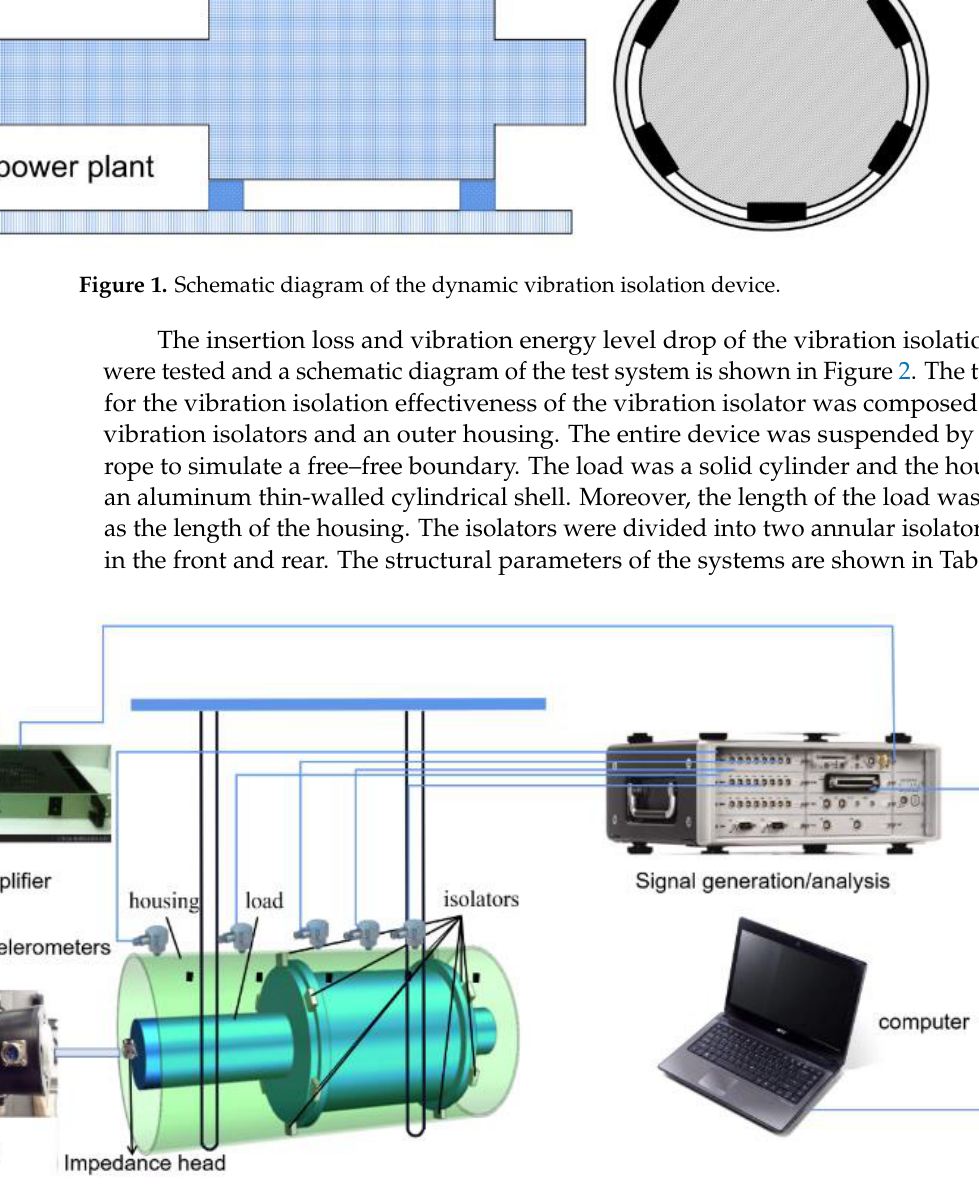
Figure 2. Schematic diagram of the vibration isolation system test. Table 1. The structural parameters of the test system.